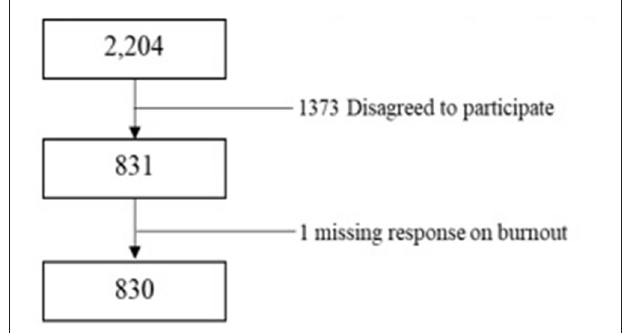
FIGURE 1 | Flowchart of analysis data for